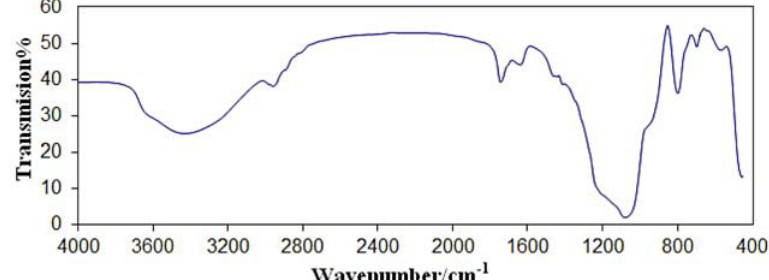
Figure 4. FT-IR spectrum of L-prol-N-pMCM-41.